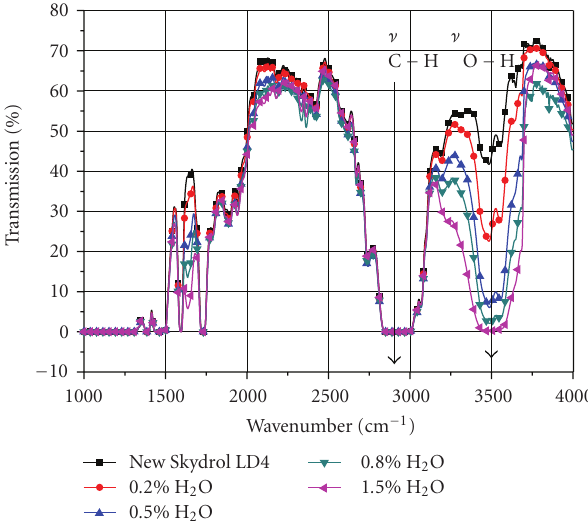
Figure 2: IR transmission spectra of pure and water-contaminated samples of Skydrol LD4.